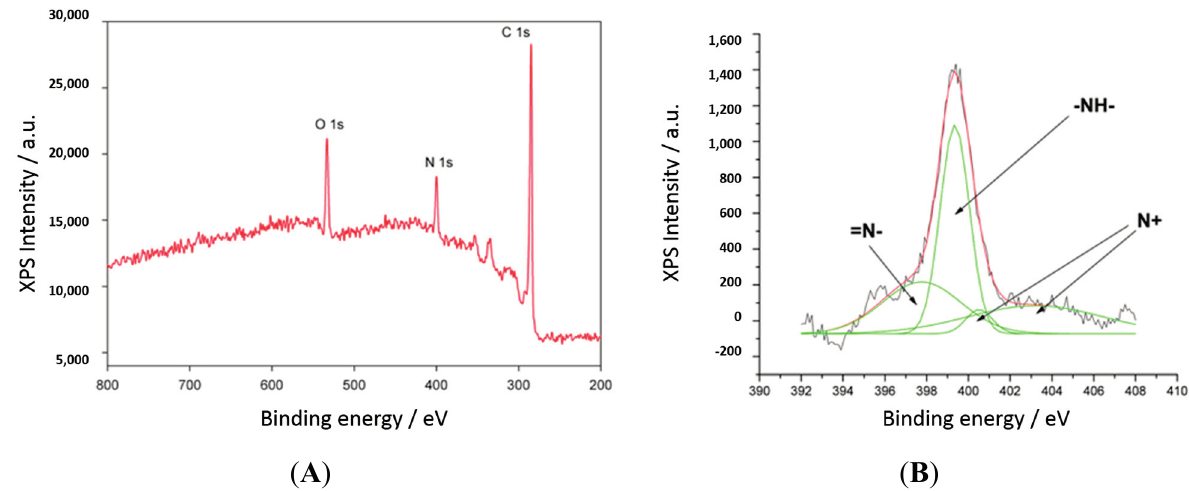
Figure 4. XPS spectra of ( A ) PANI-Nap and ( B ) nitrogen 1s